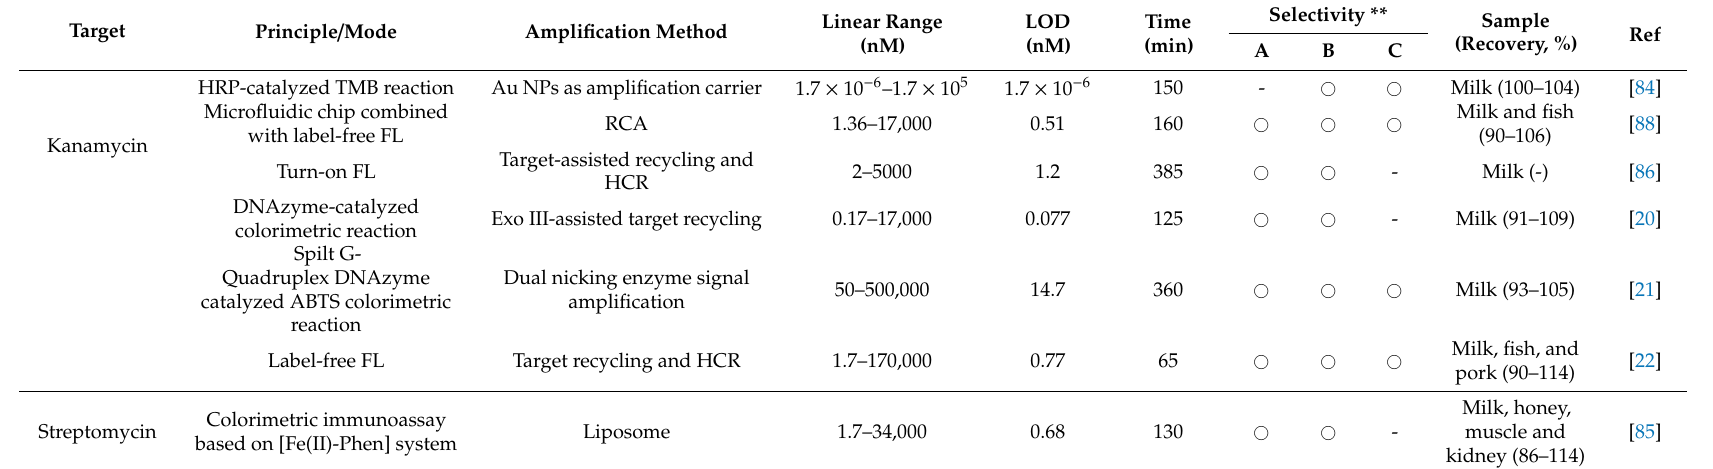
Table A4. Assay performance of the optical detection methods for AGs with amplification strategies